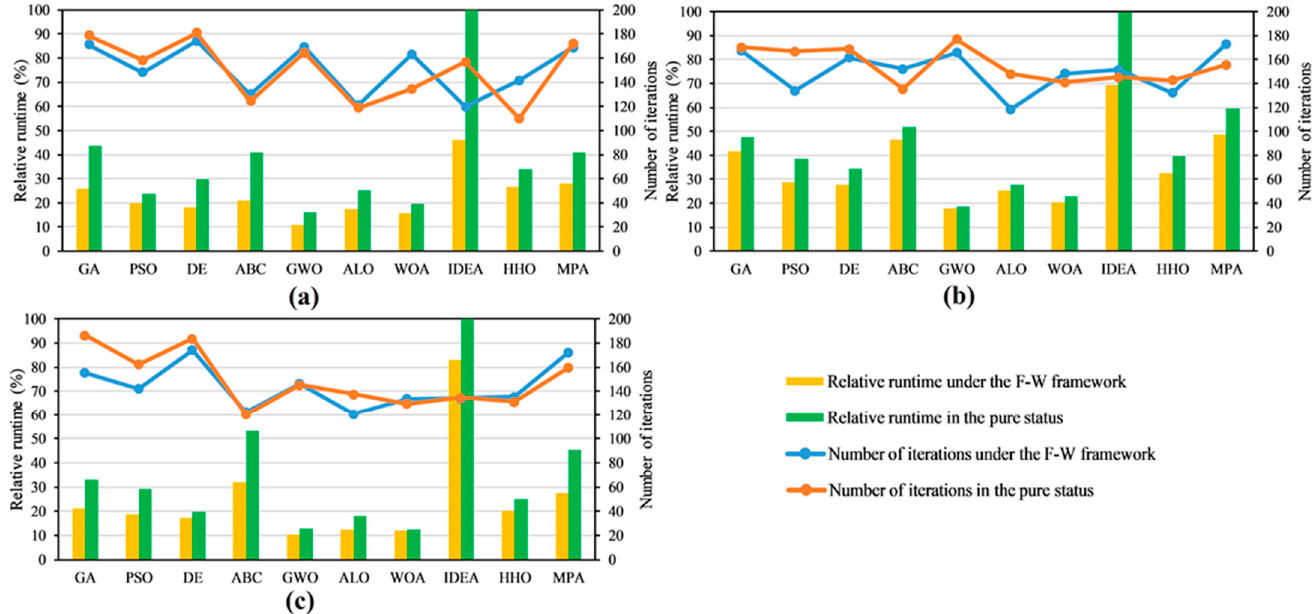
Figure 6. The relative runtime and number of iterations of different algorithms on ( a ) the Indian Pines dataset, ( b ) the Salinas dataset, and ( c ) the KSC dataset. In terms of the relative runtime, each F–W–SIEA runs faster than the corresponding pure SIEA. The result demonstrates that the computing efficiency of each SIEA is